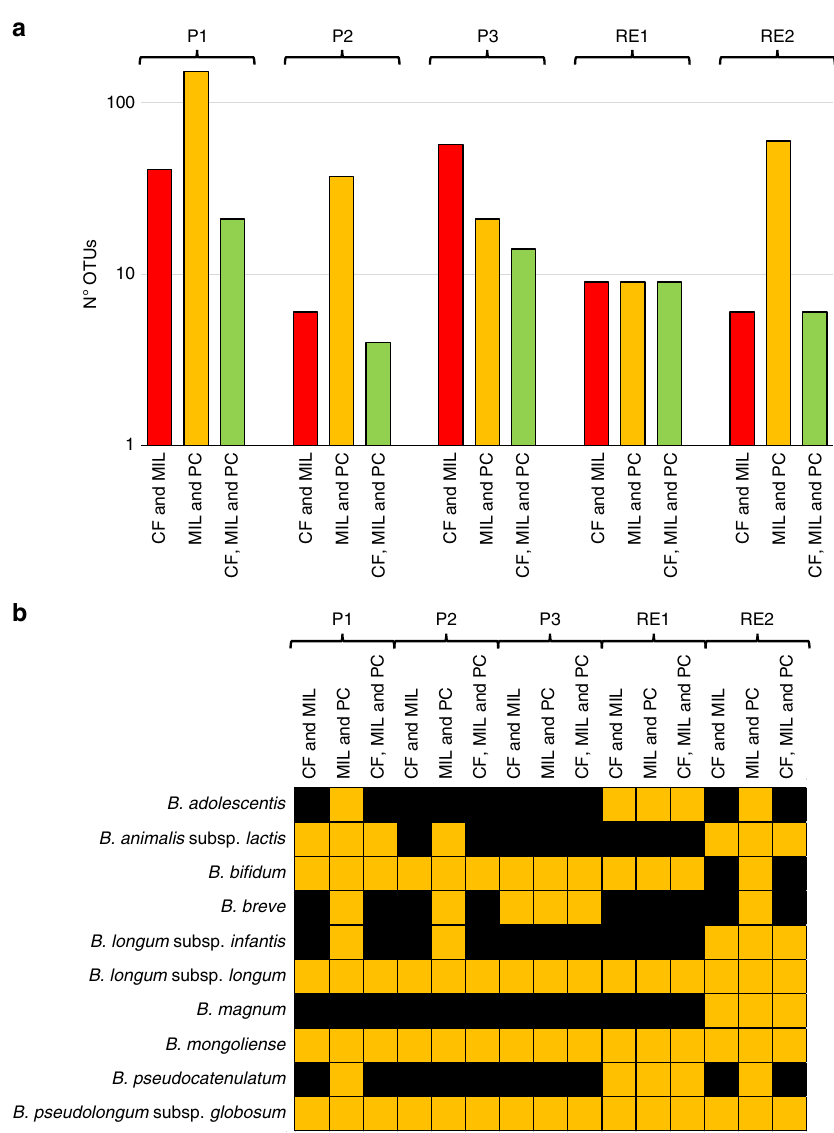
Fig. 3 Bi fi dobacterial ITS-based pro fi ling of CF, MIL, and PC samples. Panel a shows a bar plot displaying the number of OTUs shared between multiple samples collected from the same cheese making site. Panel b illustrates by means of a heat map the bi fi dobacterial taxa for which OTUs were found to be shared with a prevalence of >70% between CF, MIL, and PC samples of the same cheese making site. Source data are provided as a Source Data